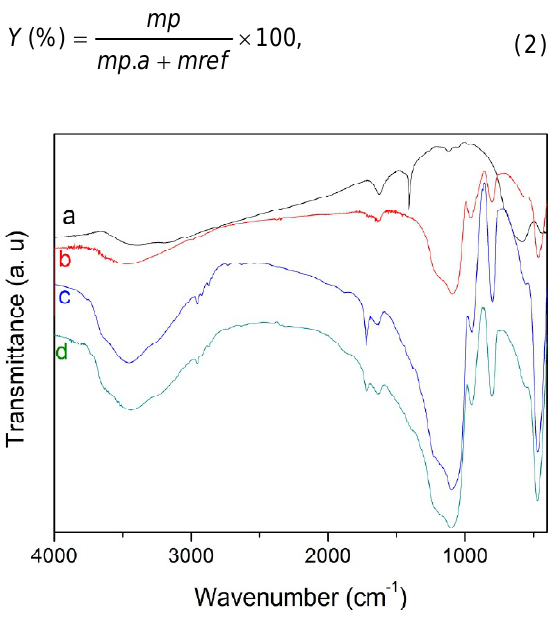
Fig. 1. Infrared spectra of (a) magnetite, (b) SiO , (c) SiO 2